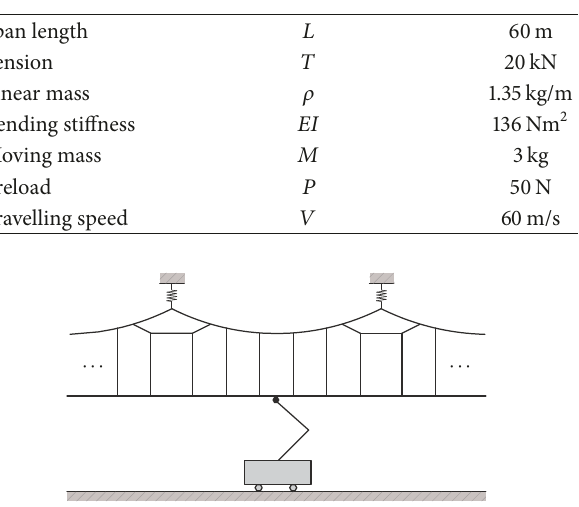
Figure 8: An elastic stitched catenary